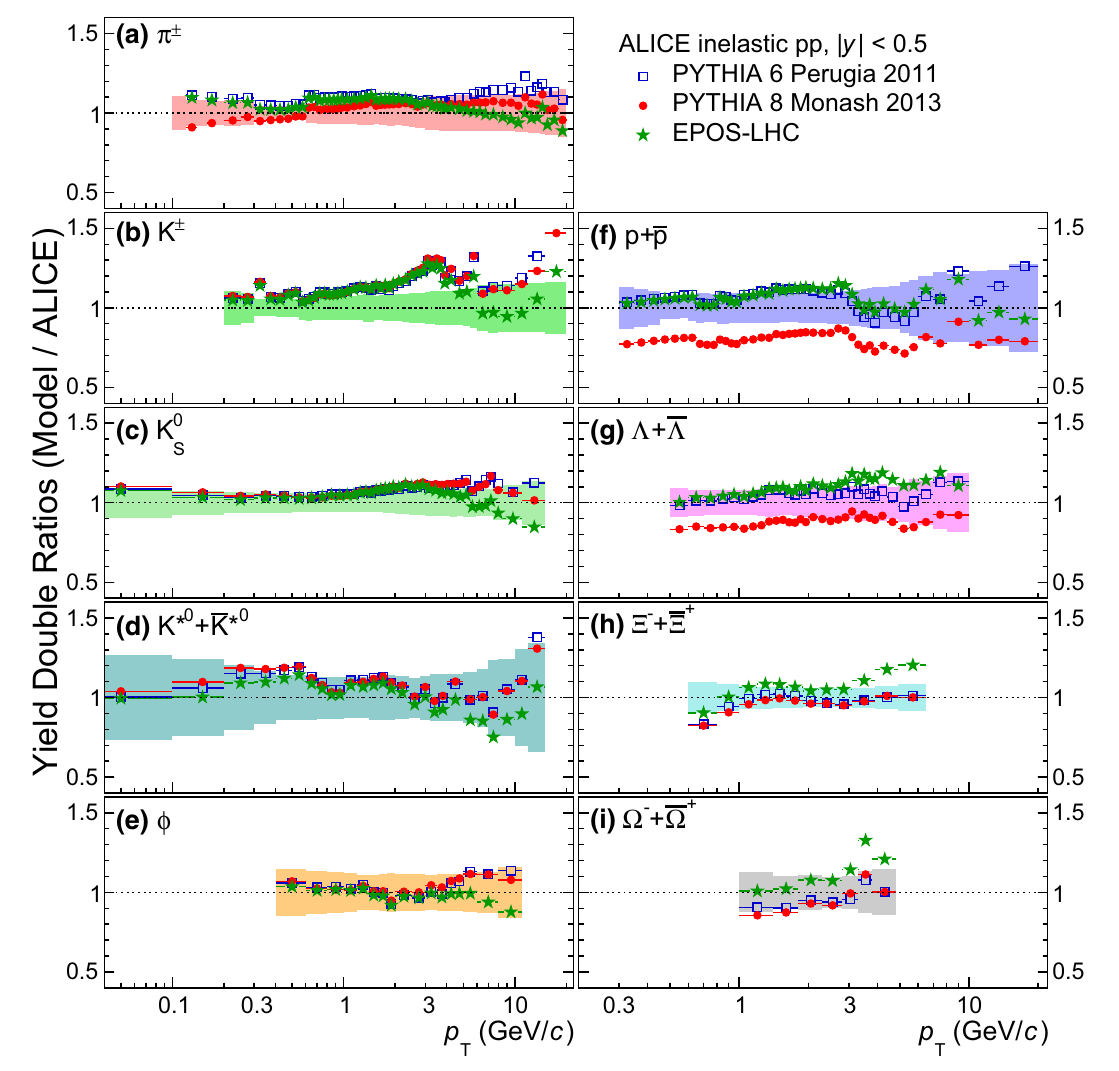
√ s = 7 TeV are from Refs. [25,27,60]. The